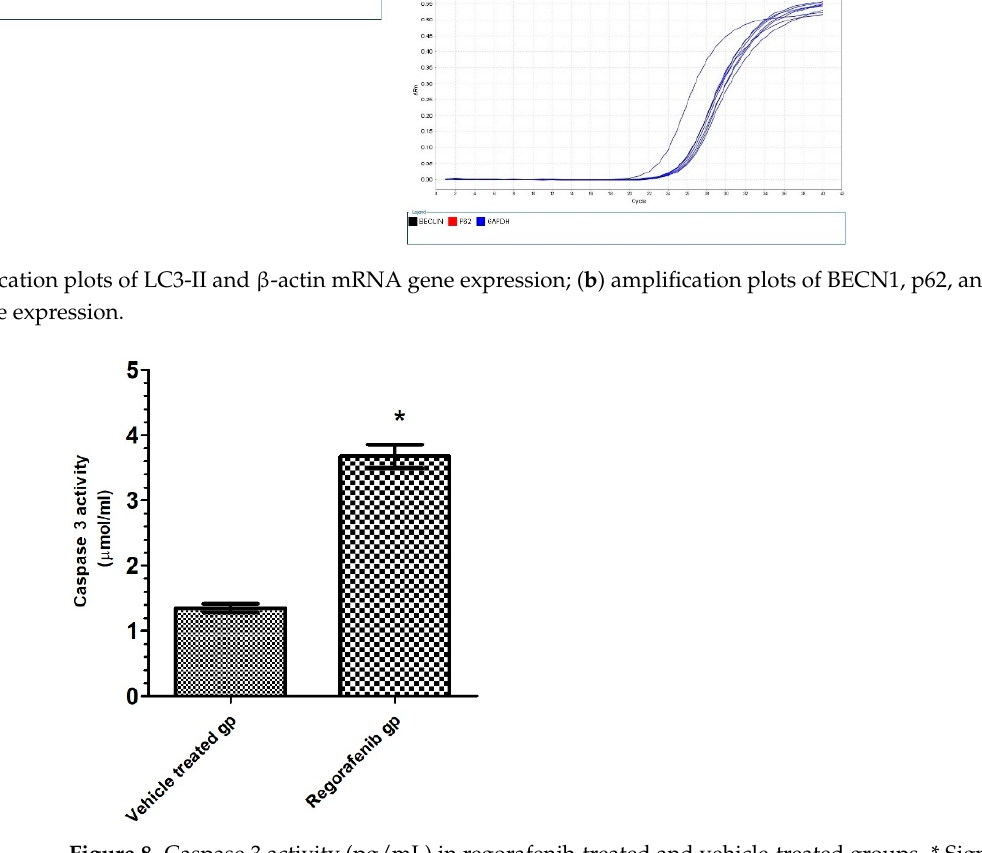
Figure 8 . Caspase 3 activity (pg/mL) in regorafenib-treated and vehicle-treated groups. * Signifi- cant from control group at p < 0.05.